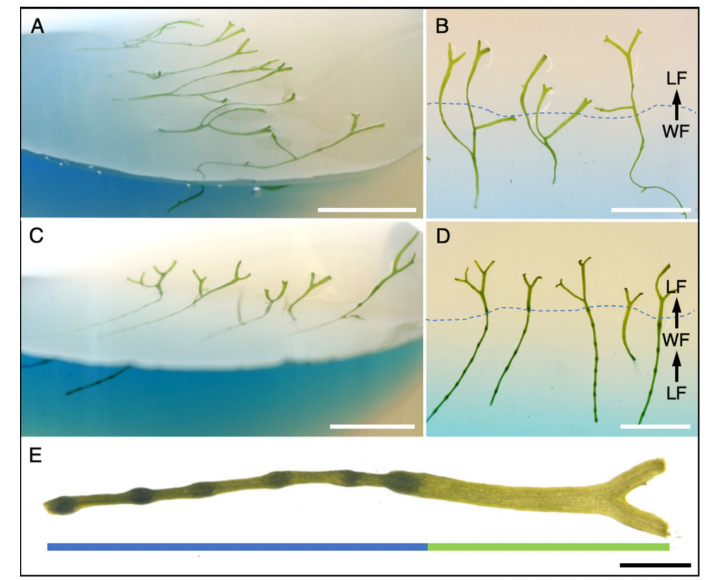
Figure 3. Phenotypic plasticity of R. fluitans 001TC plants. ( A ) WF thalli after growing for 13 days in a growth container with a slanted agar surface, liquid medium is stained with toluidine blue. WF thallus tips entered the solid phase and developed branching LF thalli. ( B ) Top view of (A) with a dashed line indicating the water / land border. ( C ) A LF culture was flooded to induce WF and archegonia formation and was then transferred into a slanted agar growth container and grown for 17 days. WF thallus tips entered the solid phase, stopped producing archegonium cavities and developed LF features, such as thallus branching. ( D ) Top view of (C). ( E ) Visualization of sequentially formed, distinct morphological adaptations within a single plant that has experienced LF–WF–LF transitions. The blue bar marks sexual WF thallus induced by flooding of the LF and the green bar indicates formation of the broadened, typical LF thallus with dichotomous branching. Scale bars A–D: 1 cm; E: 1